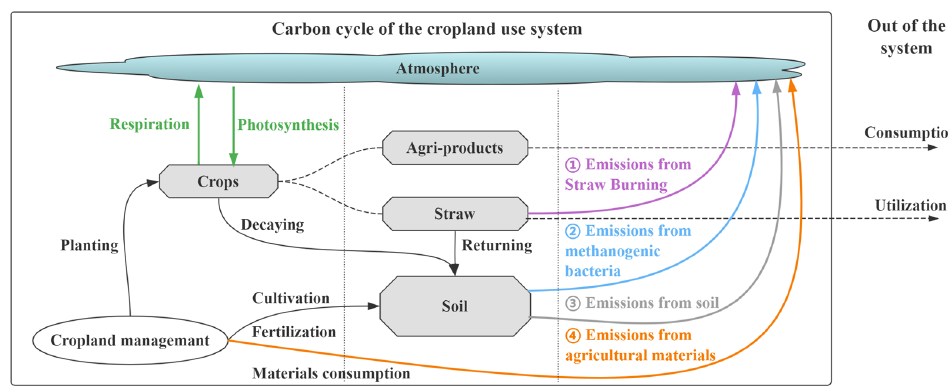
Figure 2. Carbon cycle of a cropland use system.